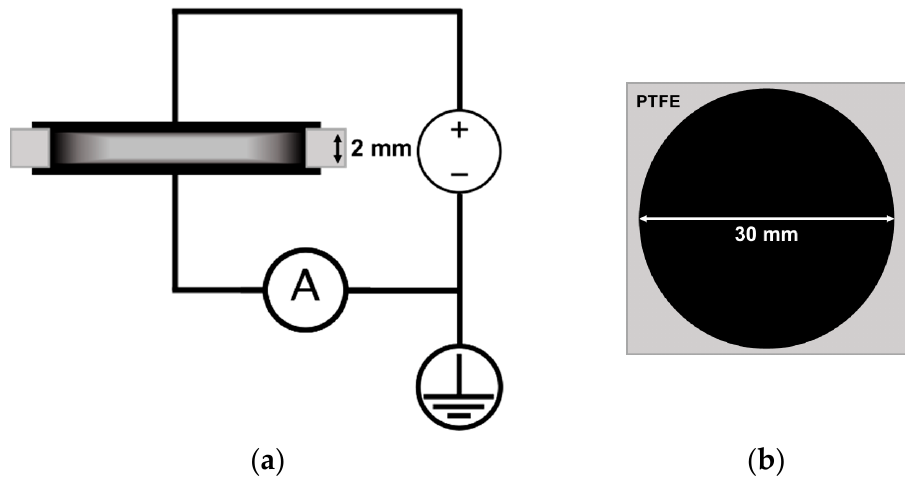
Figure 4. Experimental two-electrode circuit for measuring the electrical resistance of a composite melt: ( a )—side view; ( b )—top